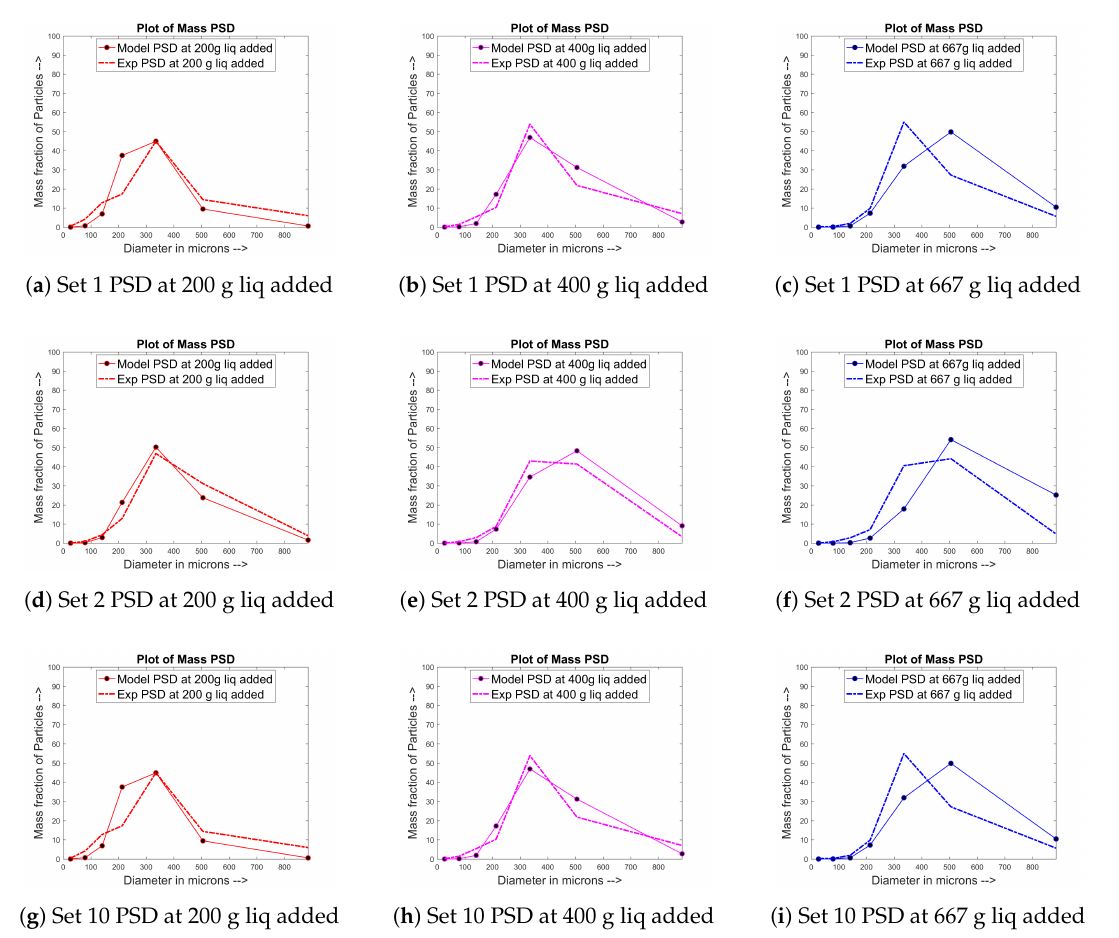
Figure 1. Experimental vs. model particle size distributions (PSDs) for Sets 1, 2 and 10 that were used for training the